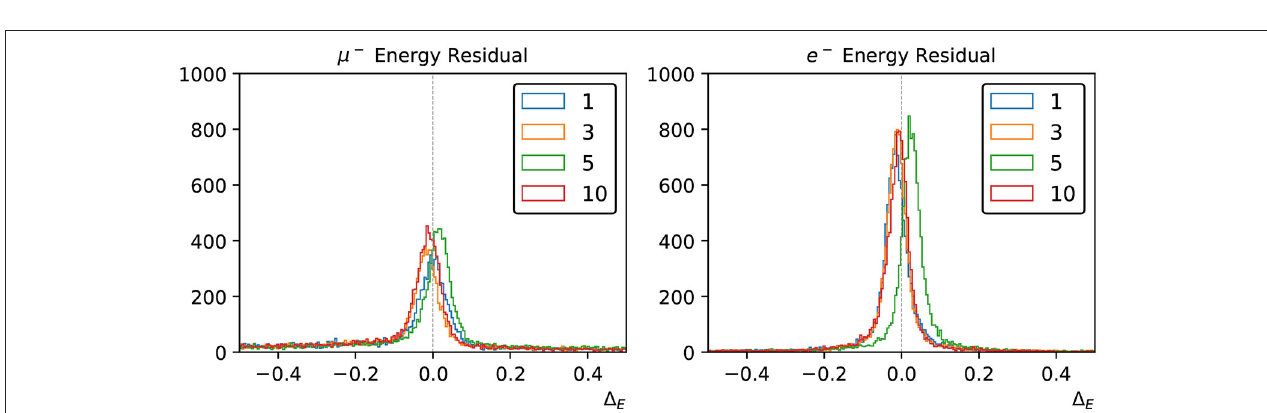
FIGURE 8 | Energy reconstruction performance for muons (left) and electrons (right) using the charge-only loss functions with 1, 3, 4, and 10 Gaussian components.